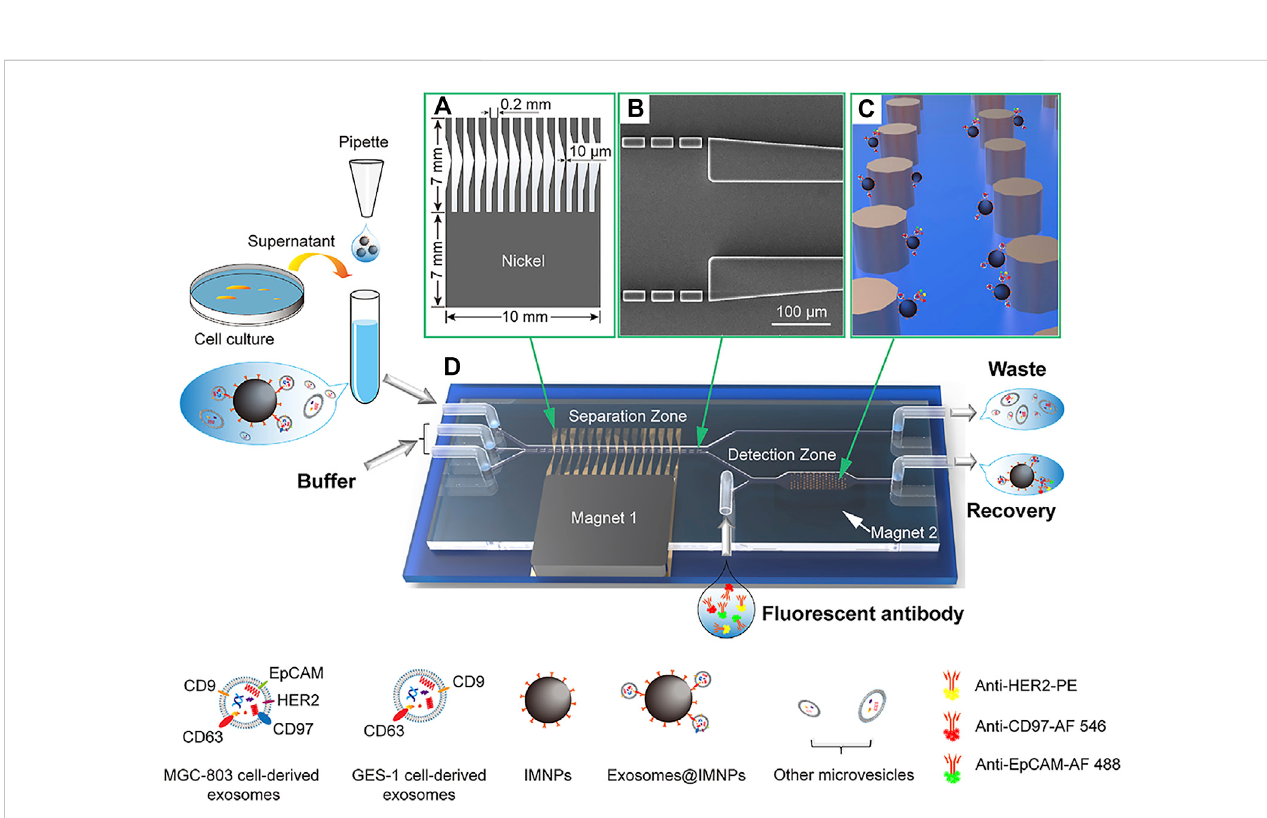
FIGURE 7 ExoSD chip for exosome separation by IMNPs. The separated exosomes@IMNPs were captured on the Ni cylinder array and labeled with fl uorescent antibodies for detection. (A) Scheme of the Ni comb-like structure for local magnetic fi eld and magnetic fi eld gradient enhancement. (B) SEM image of the micro fi lter. (C) Schematicdiagramofcapturing exosomes@IMNPsbyNicylindricalarray. (D) Three-dimensional diagramoftheExoSDchip.Reproducedwith permission from (Yu et al.,